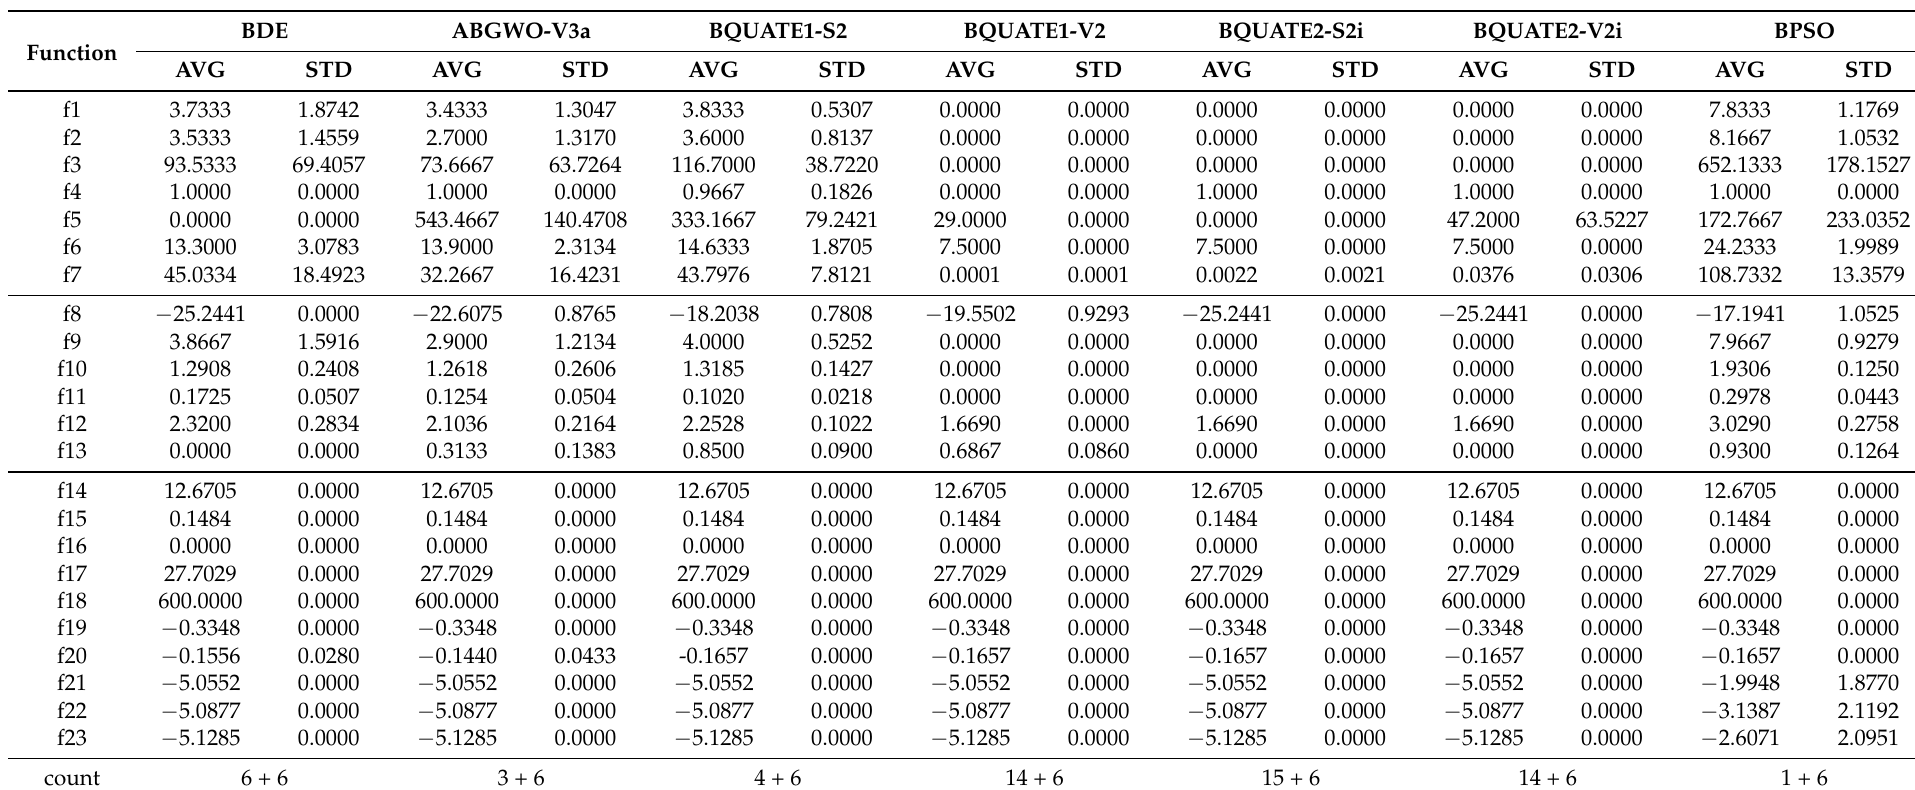
Table 13. The statistical results of BDE, ABGWO-V3a, BQUATE1-S2, BQUATE1-V2, BQUATE2-S2i, BQUATE2-V2i, and